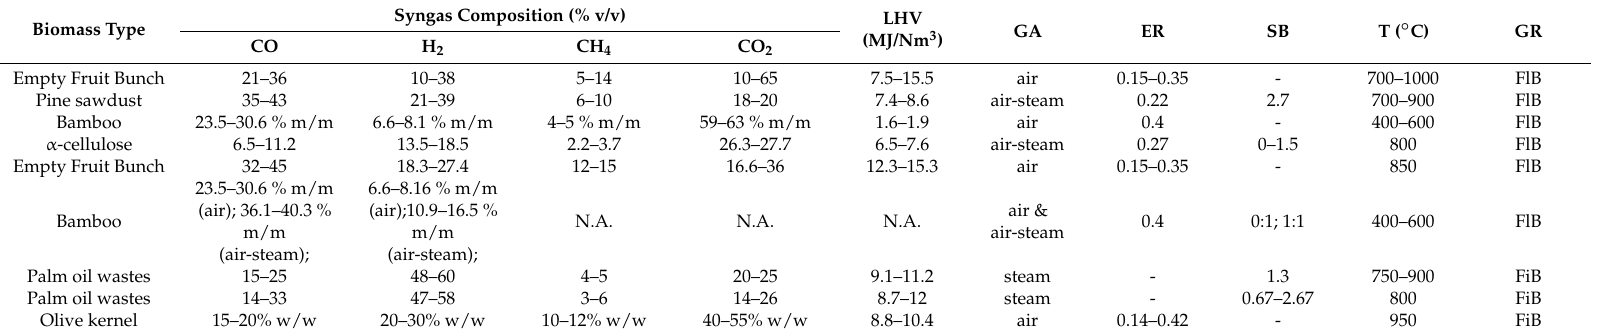
Table 6. Composition of syngas from several biomass types